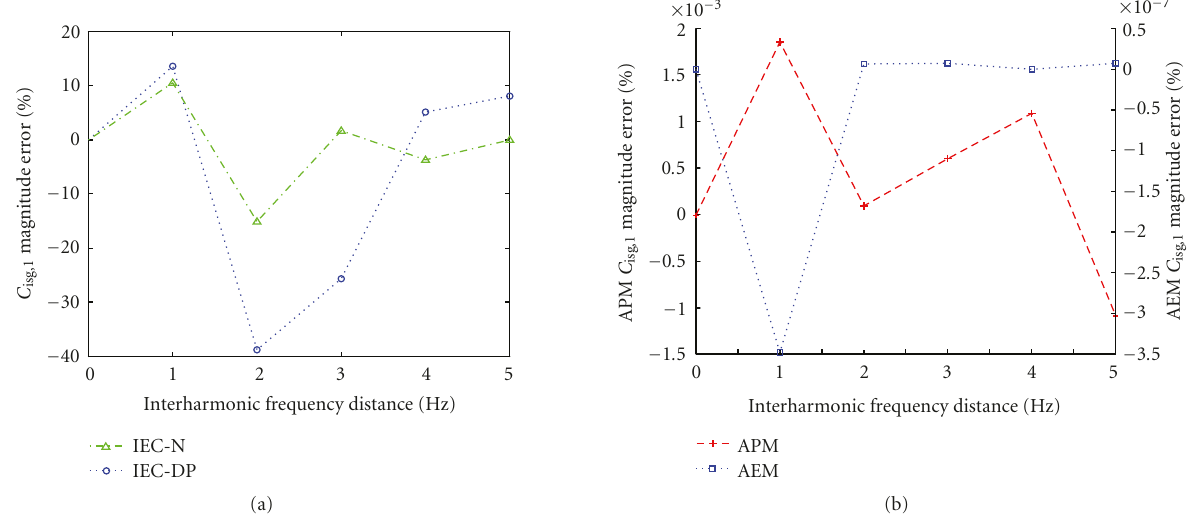
Figure 10: Case study 3: interharmonic subgroup C isg,1 magnitude error (in %) versus the distance of interharmonic tones from 75Hz: (a) IEC-N (- · - Δ ) and IEC-DP (dotted line ◦ ), (b) APM (dotted line +) and AEM (dotted line (cid:3)